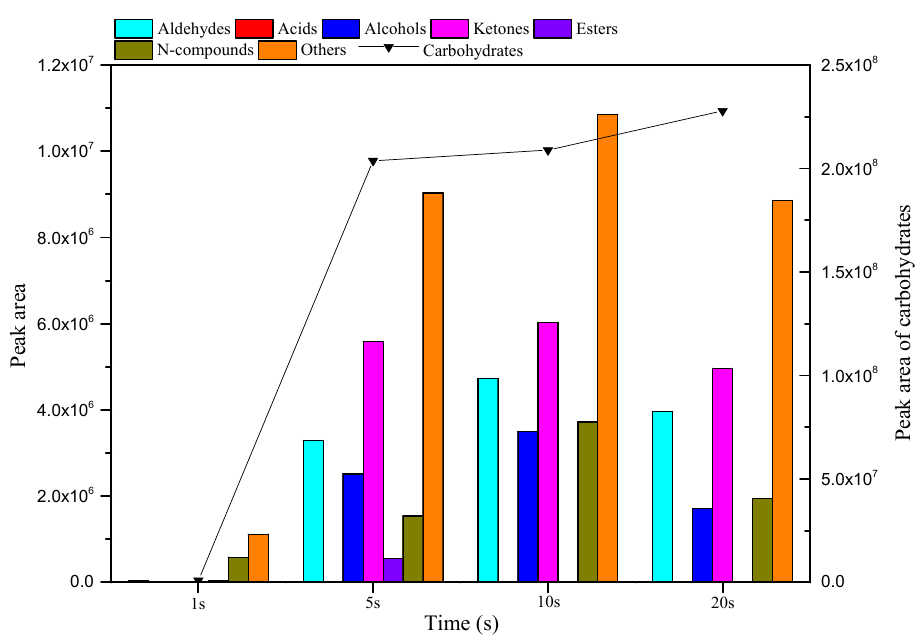
Figure 5. Yields of various compounds in bio-oil obtained from MC pyrolysis at 500 °C with different reaction times.